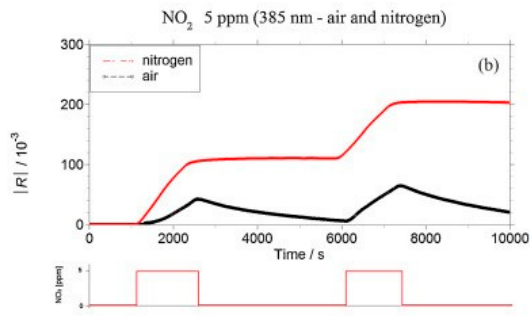
Figure 6. 5 ppm NO 2 sensing plot of ZnO thin film at room temperature as a function of ( a ) light